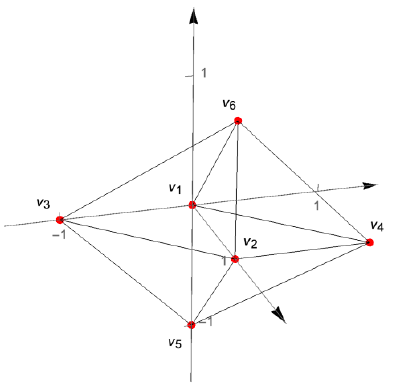
Figure 4 . Toric diagram of Q 1 ; 1 ; 1